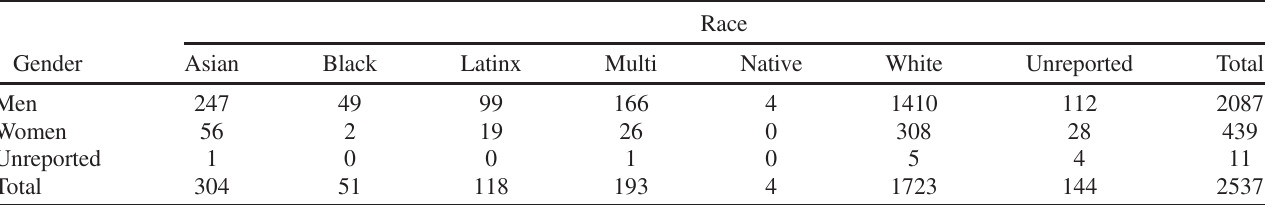
TABLE II. Counts of applicants by gender and race who provided both GPAs and physics GRE scores.